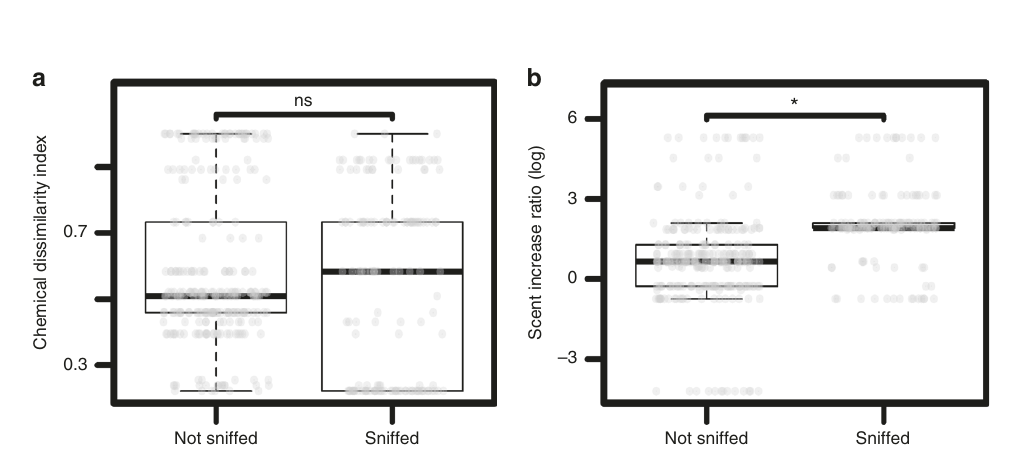
Fig. 2 Ripe fruit olfactory conspicuity and monkey snif fi ng behaviour. a Chemical dissimilarity between conspeci fi c ripe and unripe fruits calculated as Bray – Curtis dissimilarities based on the relative amounts of VOCs. b Scent increase ratio: total amount of scent emitted by an individual ripe fruit divided by the total amount of scent emitted by a conspeci fi c unripe fruit. Each boxplot is overlaid on the raw data, jittered horizontally. Bars over boxes provide signi fi cance in a glmm (see Methods). ns, p > 0.05; * p < 0.05. Source data are provided as a Source Data fi le signi fi cant effect of colour vision type (Supplementary Table 1). along each of these dimensions were found in both the sniffed The impact of colour vision phenotype held irrespective of the and non-sniffed categories (Fig. 3, Supplementary Figs. 2, 3). red – green, blue – yellow or luminance contrast between ripe and When we removed trichromatic females from the analysis to unripe fruits; fruits ranging from high to low visual conspicuity examine the impact of sex alone, we found that dichromatic NATURE COMMUNICATIONS| (2019) 10:2407